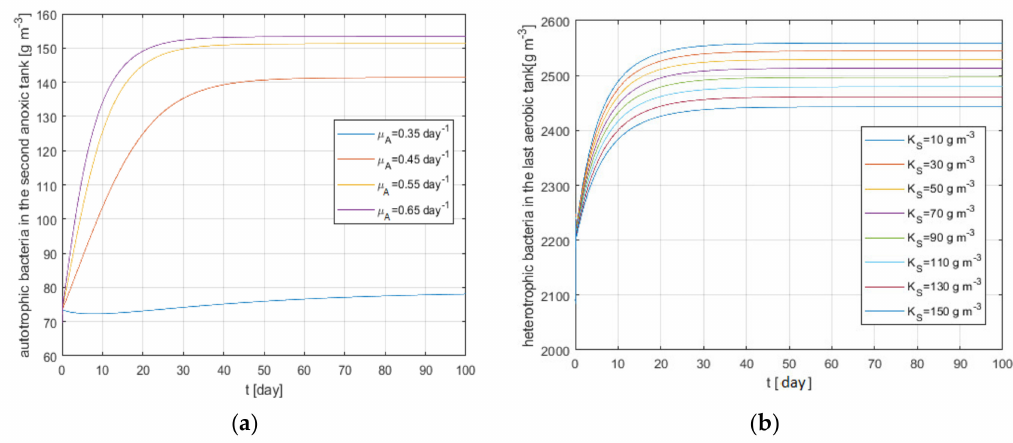
Figure 7. Autotrophs in the second anoxic tank for di ff erent values of the maximum autotrophic growth rate ( a ), heterotrophs in the third aerobic tank for di ff erent values of the substrate half saturation constant ( b ).